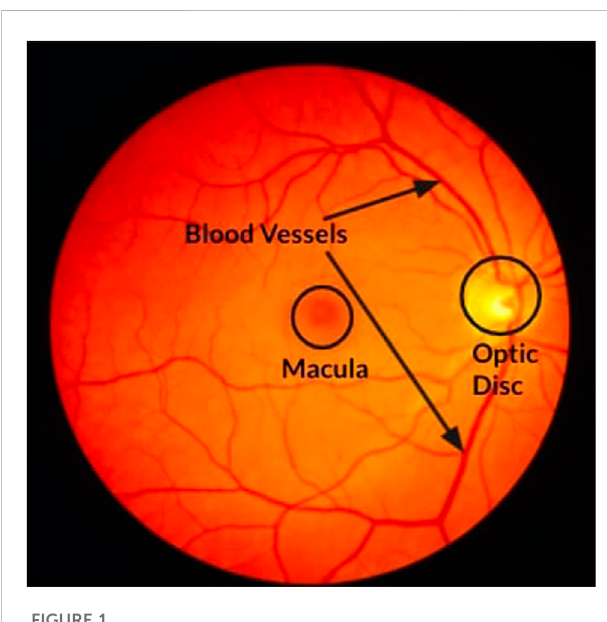
FIGURE 1 Sample fundal image showing normal landmarks, BVs, the OD, and the